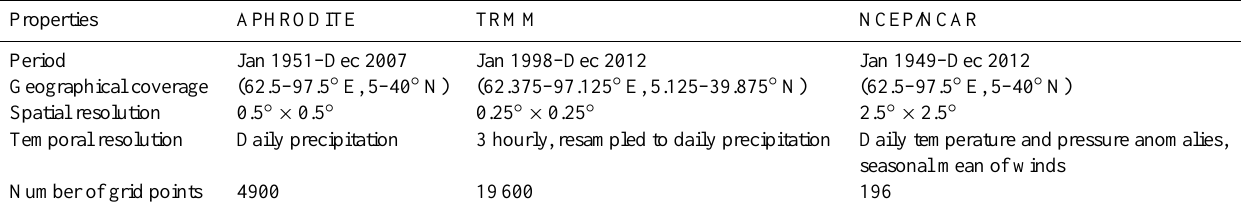
Table 1. Properties of the data sets. APHRODITE: interpolated rain-gauge data (Yatagai et al., 2009). TRMM 3B42V7: satellite-derived data (Huffman et al., 2007). NCEP/NCAR: reanalysis data (Kalnay et al.,